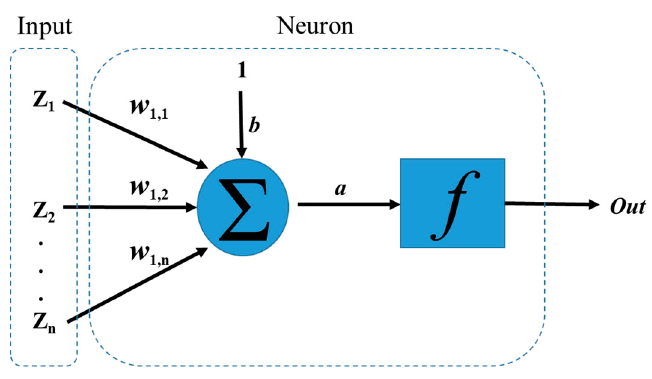
Figure 1. Simple scheme of a neuron.